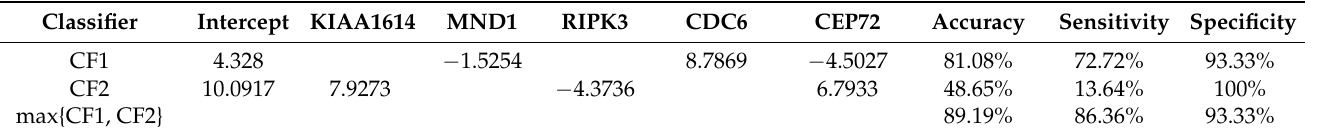
Table 16. GSE179448: Characteristics of the top-performing five-gene classifier. CF1 and CF2 are the first and second individual classifiers for data of COVID-19 hospitalized patients vs. healthy controls.